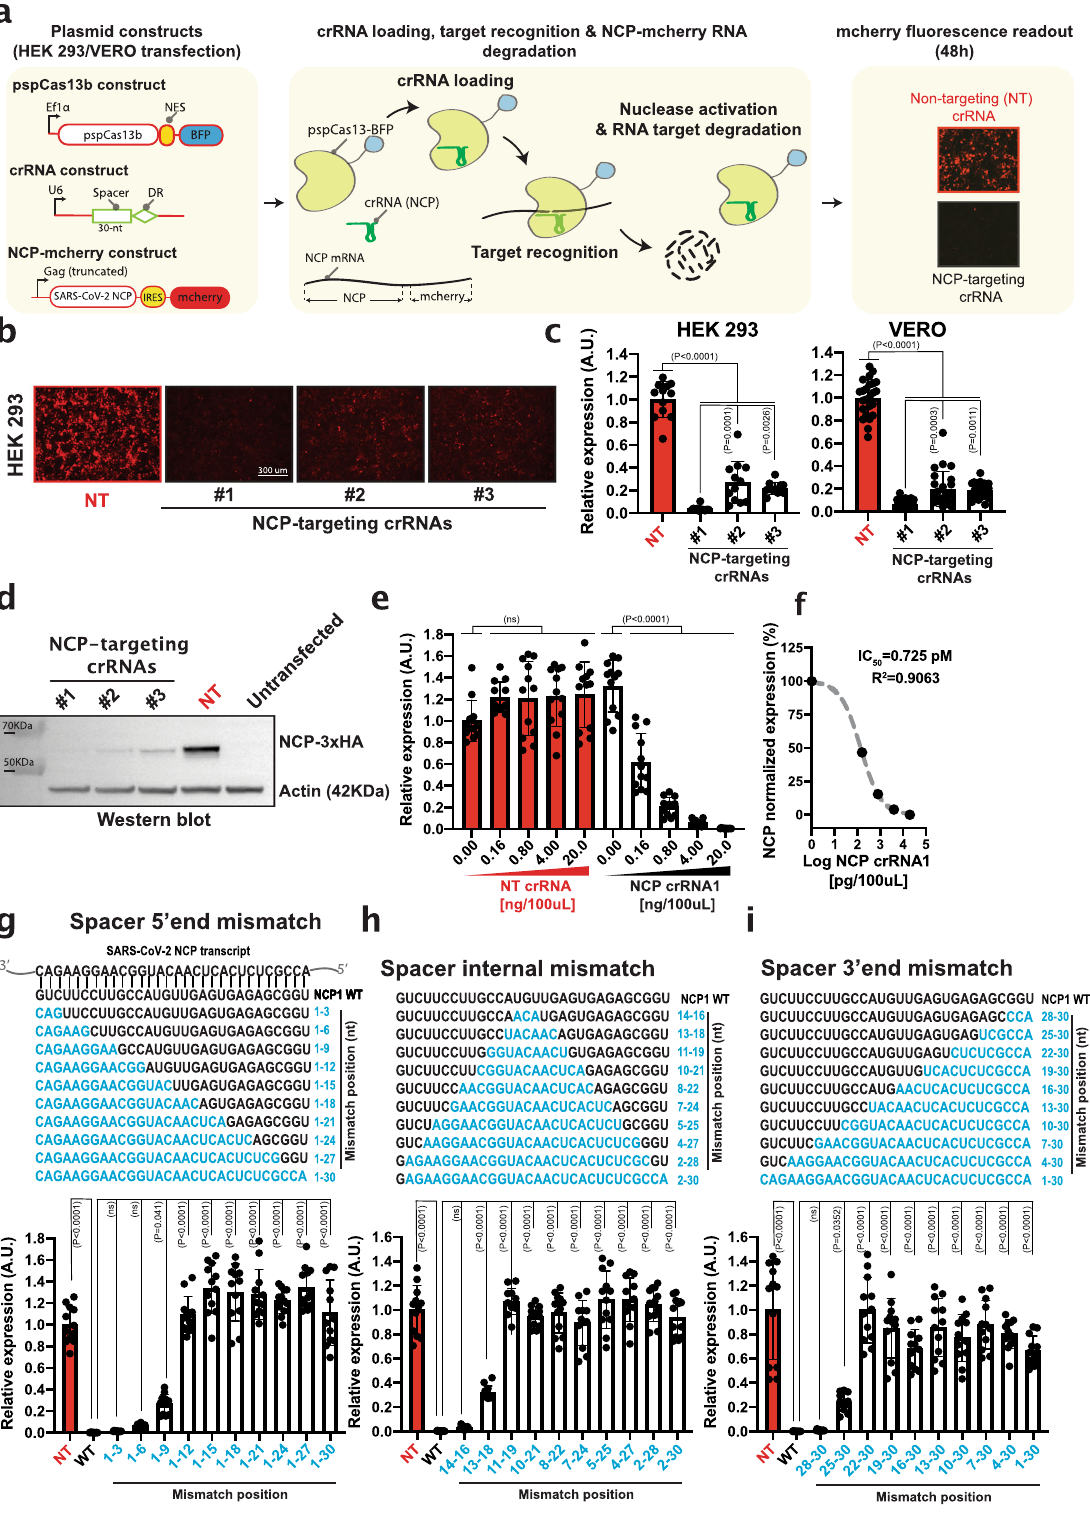
to remain effective against spontaneous mutations. We re- nucleotide mismatch at spacer positions 1, 5, 10, 15, 20, 25, and 30 and compared their silencing ef fi ciency to their